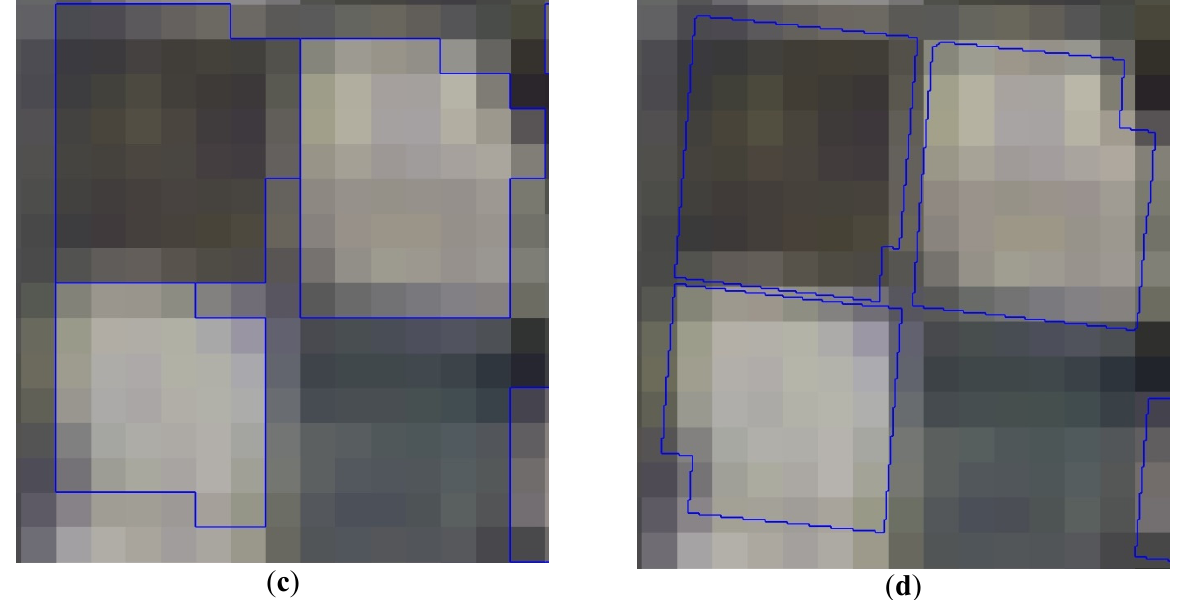
Figure 3. Segmentations for a detailed area of 225 m × 240 m showing orthoimages as the background: ( a ) manual digitizing on WV2 pan-sharpened orthoimage MS RGB; ( b ) WV2 MS segmentation using an enhanced resolution of 0.8 m per pixel; ( c ) Landsat 8 pan-sharpened orthoimage with the original GSD (15 m); ( d ) Landsat 8 pan-sharpened orthoimage using 0.9375 m